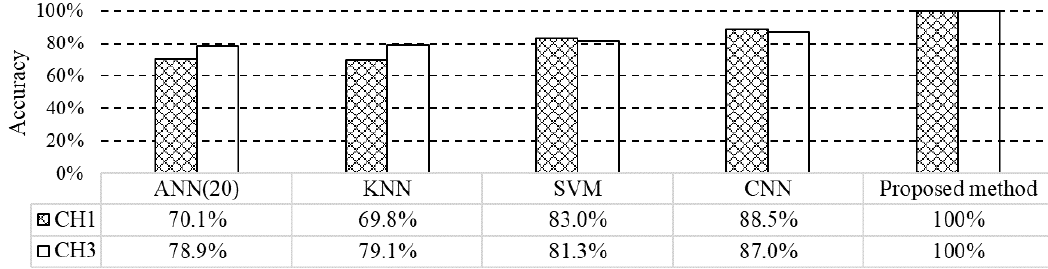
Figure 13. Comparison of recognition accuracies.